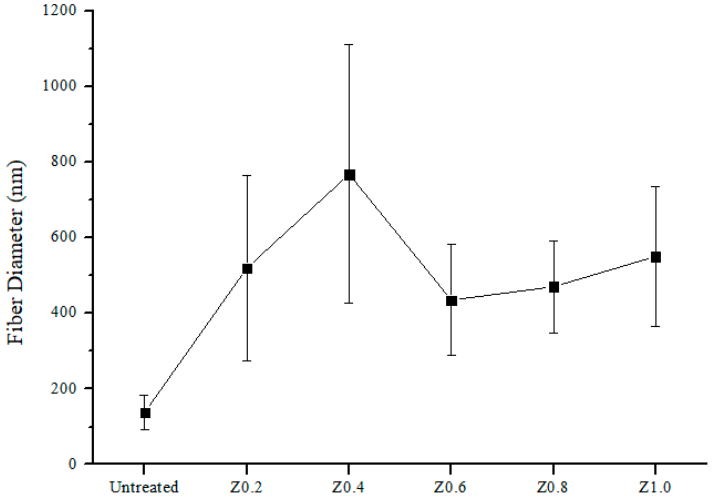
Figure 4. FESEM images (magnification 5000×) of untreated nylon 6,6 and nylon 6,6/ZIF-8 NFM. The inset shows the presence of ZIF-8 on the structure of NFM.